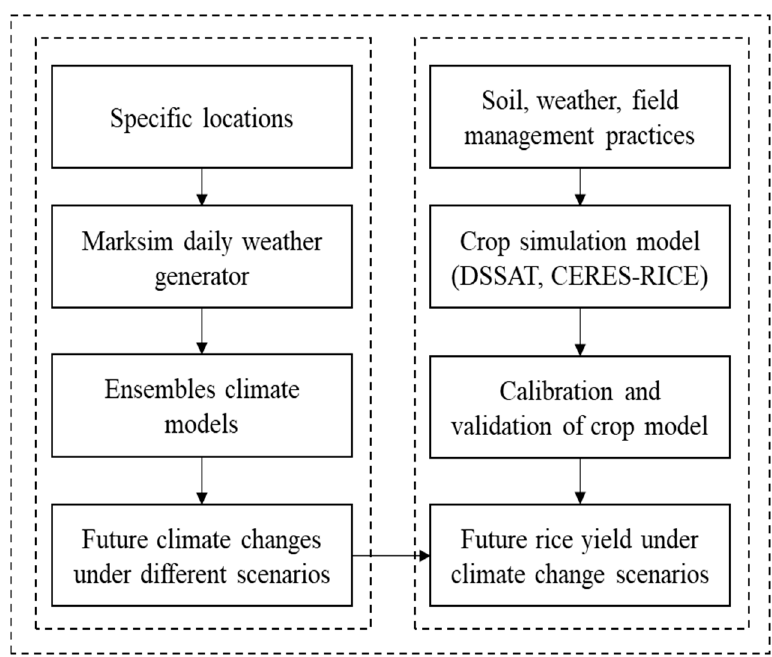
Figure 2. The methodological framework for assessing future rice yield.